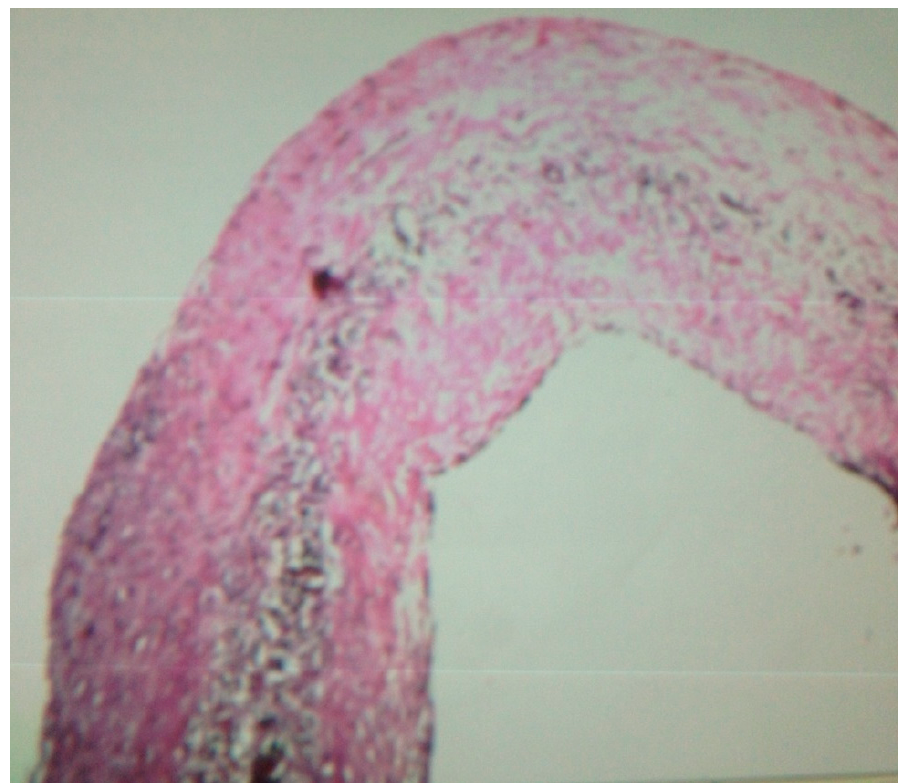
Figure 4. Low-power view of pericardial cyst showing the mesothelial lining and cyst wall composed of loose connective tissue with blood vessels.